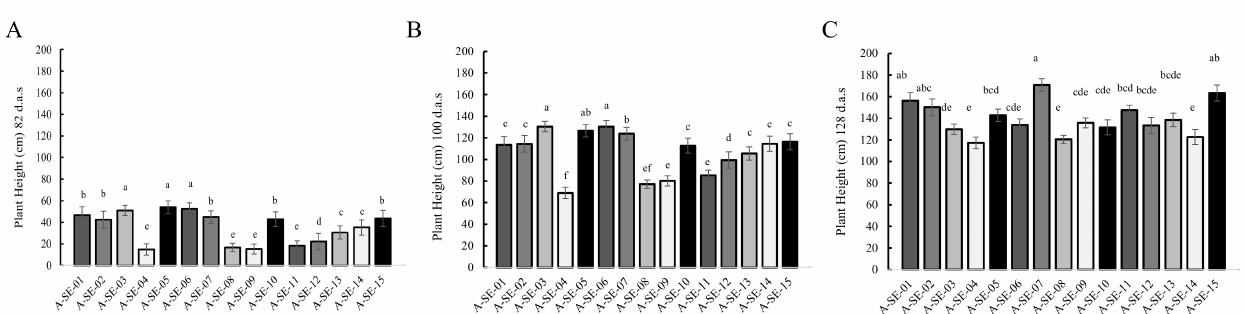
Figure 1. Plant height. Plant height (cm) was determined in the 15 cultivars analyzed at ( A ) 82, ( B ) 100, and ( C ) 128 d.a.s. Error bars represent the standard deviation. Bars that do not share the same letters show statistically significant differences following the Kruskal–Wallis test at a p -value < 0.05 for 82 d.a.s. and 100 d.a.s. and the ANOVA test and Tukey post-hoc test at a p -value < 0.05 for 128 d.a.s. (days after sowing).